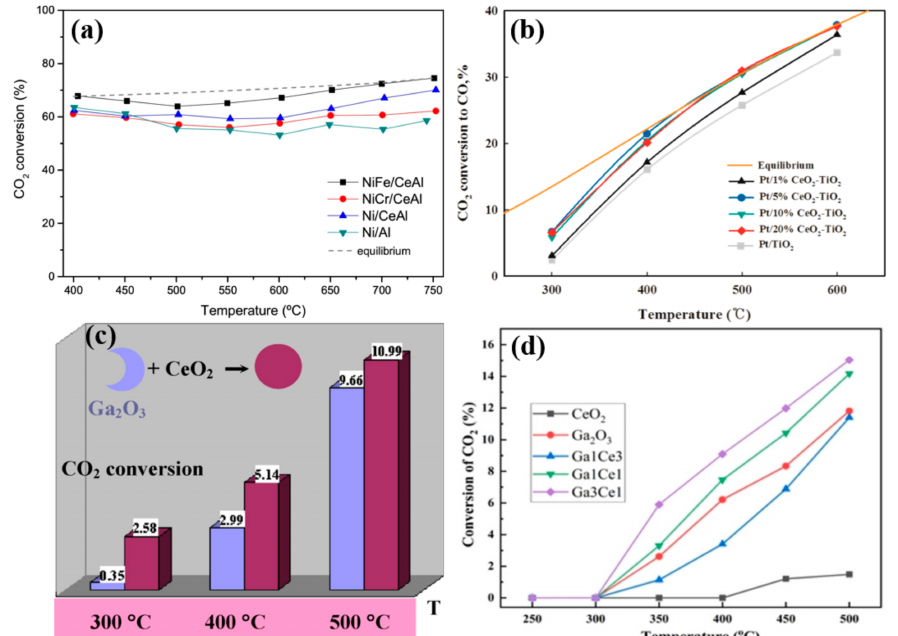
Figure 16. Effect of adding promoters on RWGS reaction: ( a ) Ni-CeAl, reprinted with permission from [167]. Copyright Elsevier, 2018, ( b ) Pt-CeTi at 400 ◦ C, ( c ) CeO 2 -Ga 2 O 3 , reprinted with permission from [99]. Copyright Elsevier, 2012, ( d ) Ga 2 O 3 − CeO 2 , reprinted with permission from [90]. Copyright Wiley,